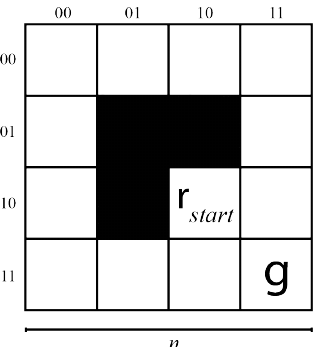
Figure 22. Environment fed to the algorithm for simulation.